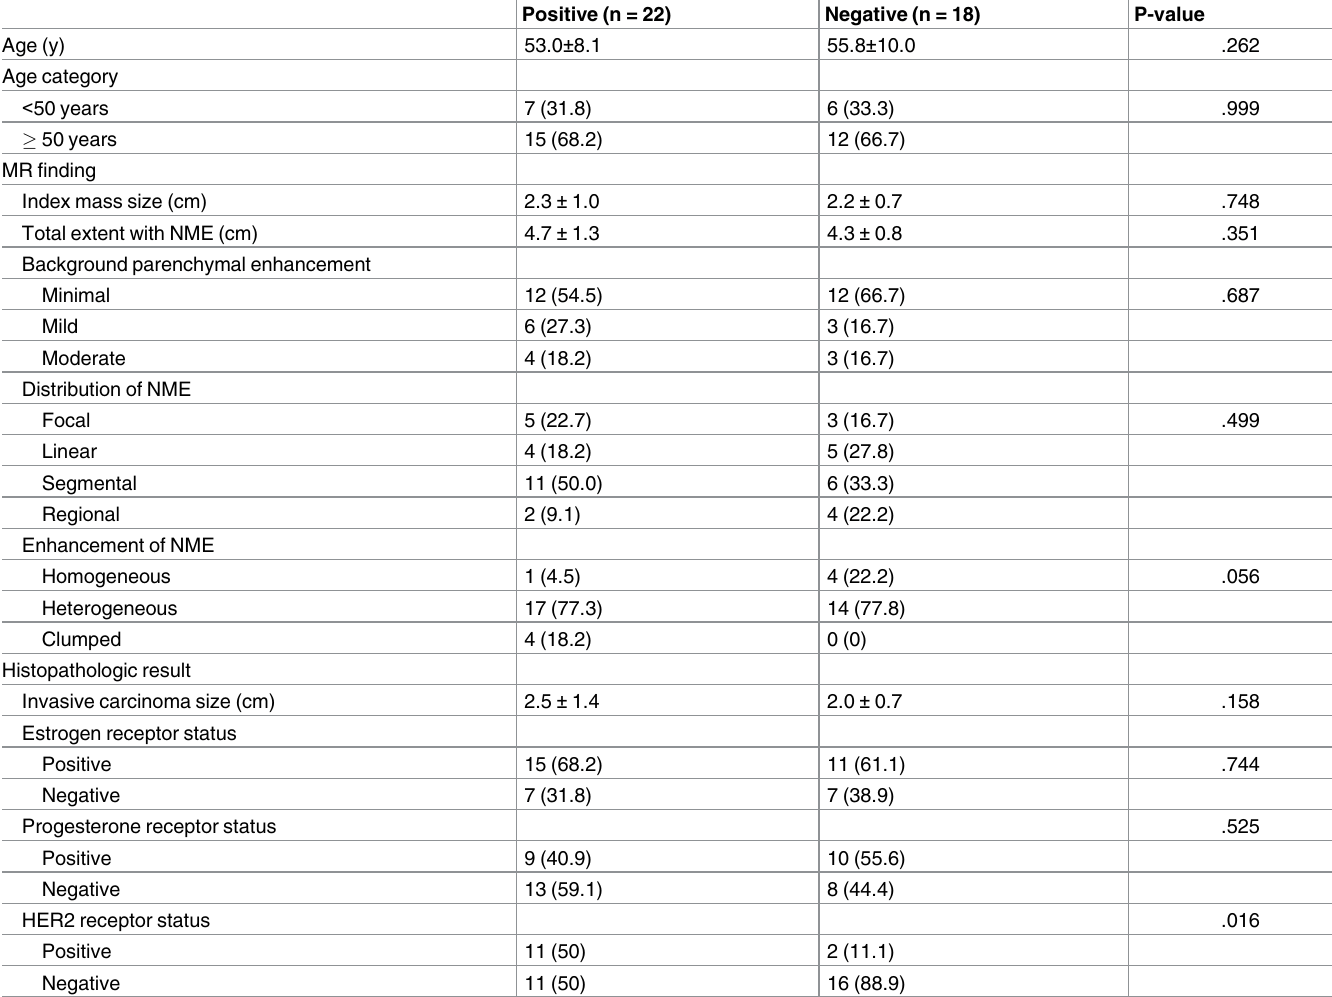
Table 2. Characteristics of patients with accompanying NME according to pathologic